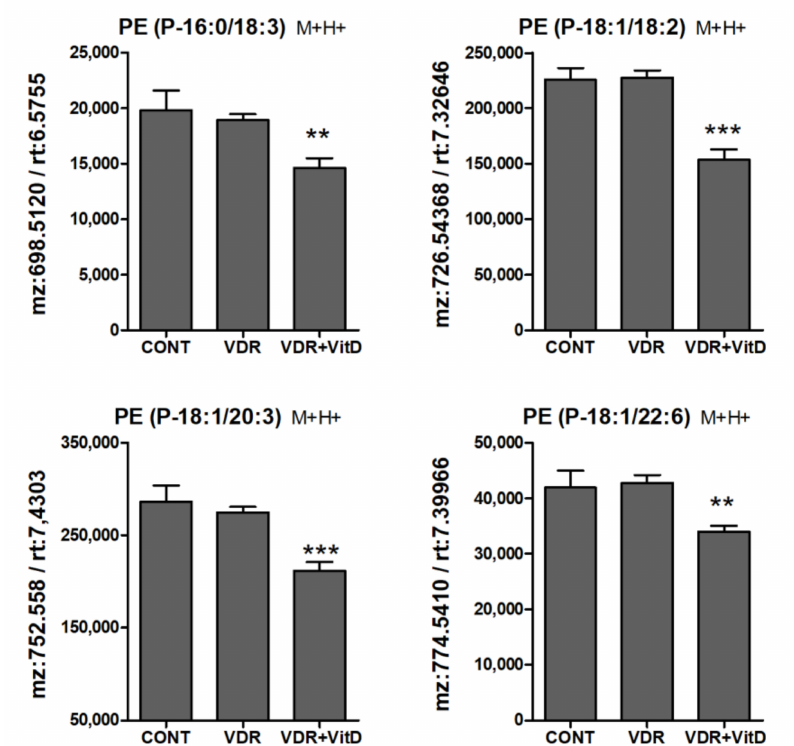
Figure 8. Relative intracellular levs of PE alkenyl (plasmenyl) ethers in cultured human hepatocytes exposed to VitD. Upcyte hepatocytes were transfected with a control Ad-C or with Ad-VDR for 48 h. Then, 10 nM VitD (VDR + VitD, n = 4) or vehicle (CONT, n = 3 and VDR, n = 4) were added for 24 h. Cells were washed, and intracellular metabolites extracted and analyzed by UPLC-MS as described in Materials and Methods. * p < 0.05, ** p < 0.01 and *** p < 0.001 VDR + VitD vs.